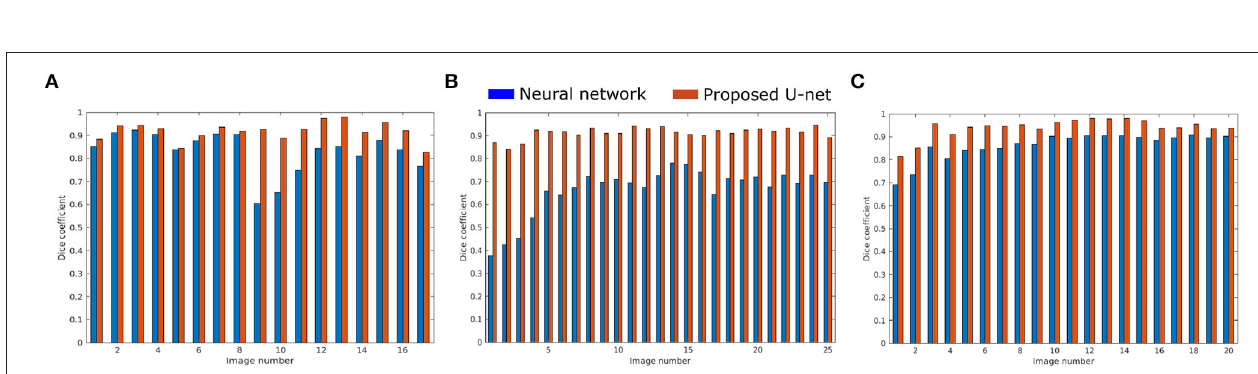
FIGURE 9 | Performance of neural network (blue) and proposed U-net (orange) segmentation models on (A) 17 arabidopsis, (B) 25 barley, and (C) 20 maize side view